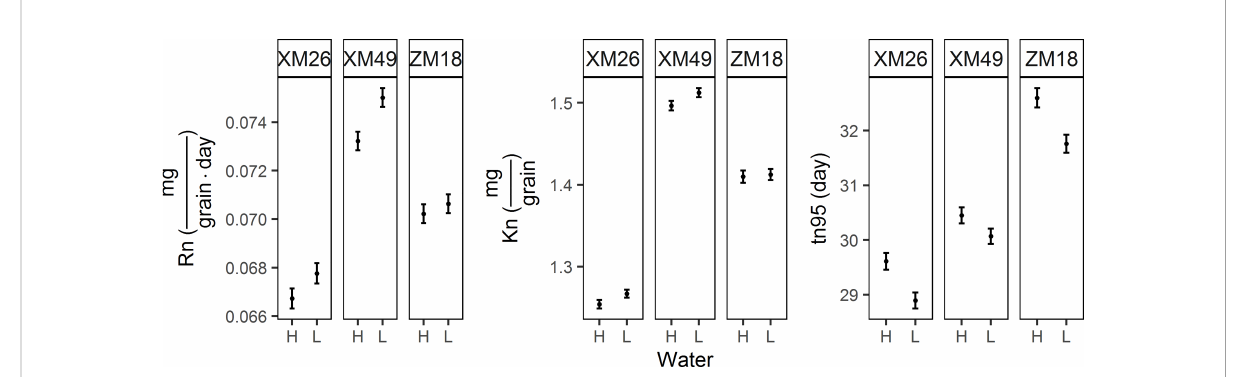
FIGURE 7 Parameters of grain nitrogen accumulation of different winter wheat genotypes subjected to different irrigation treatments. Error bars indicate the con fi dence interval of themean. Rn, maximum rate of grain nitrogen accumulation; Kn, fi nal grain nitrogen weight; tn95, duration of grain nitrogen accumulation. XM26, Xinmai-26; XM49, Xinmai-49; ZM18, Zhoumai-18; H, high-water treatment; L, low-water